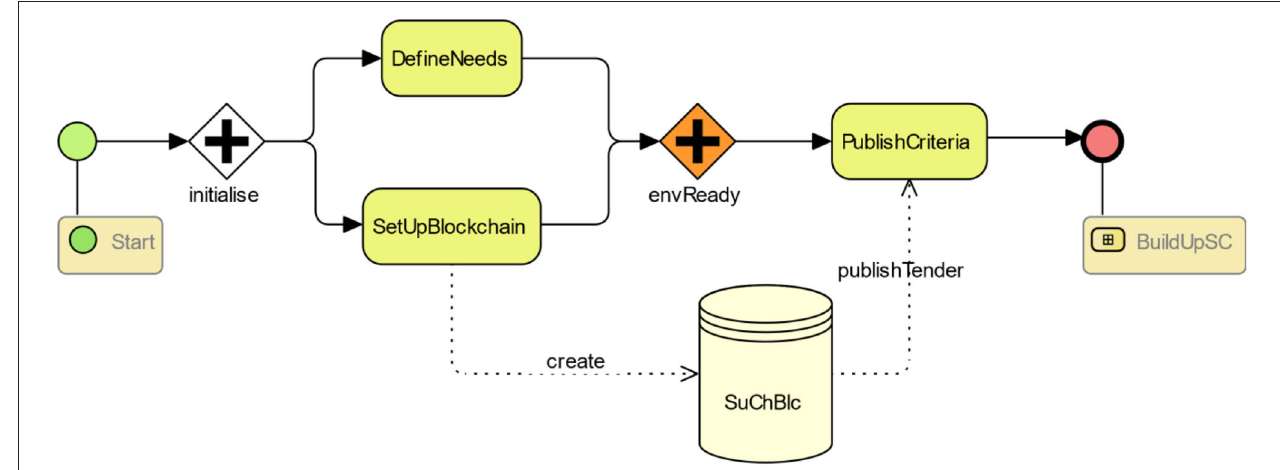
FIGURE 8 | The sub-process for originating a contract and setting up the